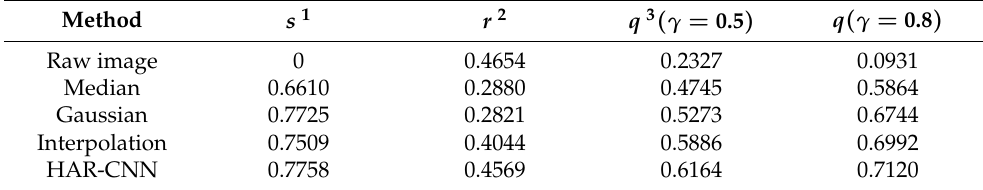
Table 2. Comparison of quality measures for various honeycomb removal